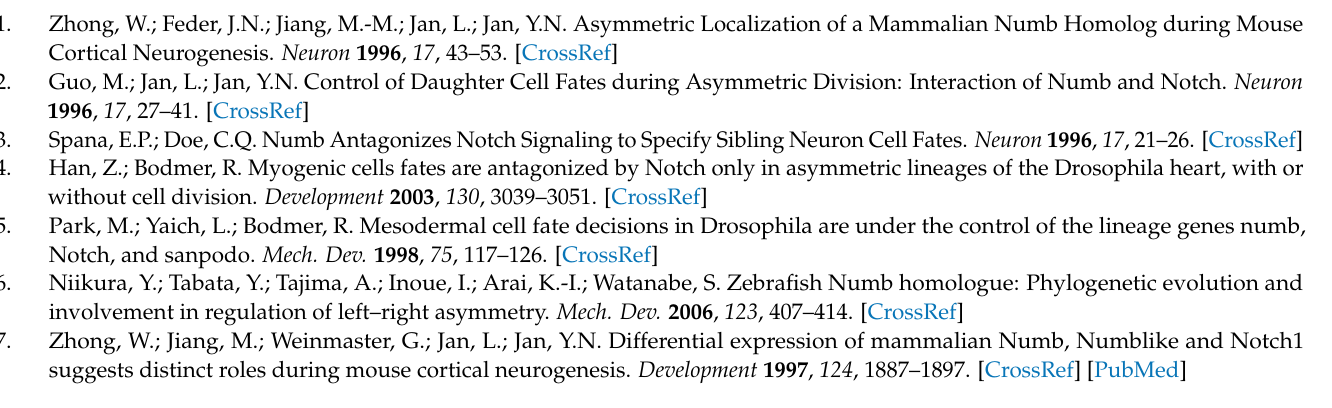
Western Blot; Table S1: qPCR primer list; Table S2: mRNA deep sequencing upregulated genes; Table S3: mRNA deep sequencing downregulated